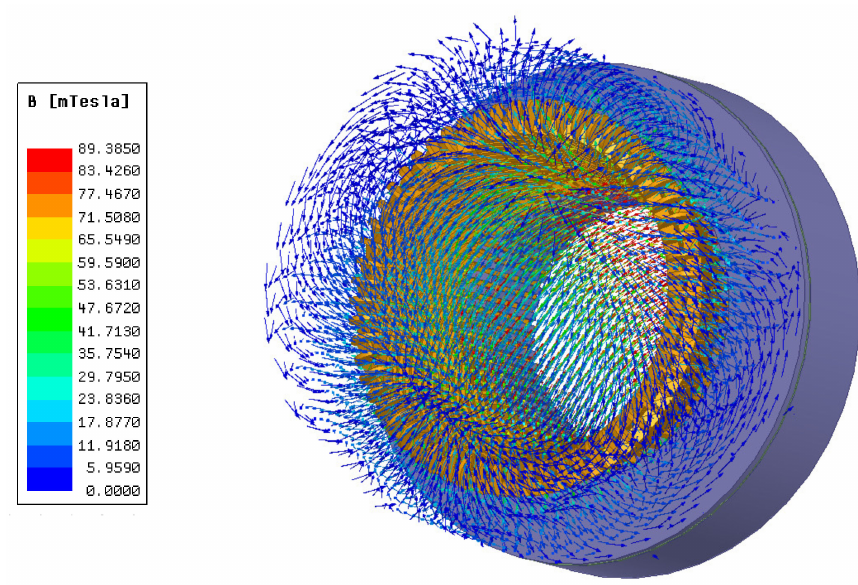
Figure 3. Distribution of the magnetic flux density B in the region of the stator end windings of the synchronous